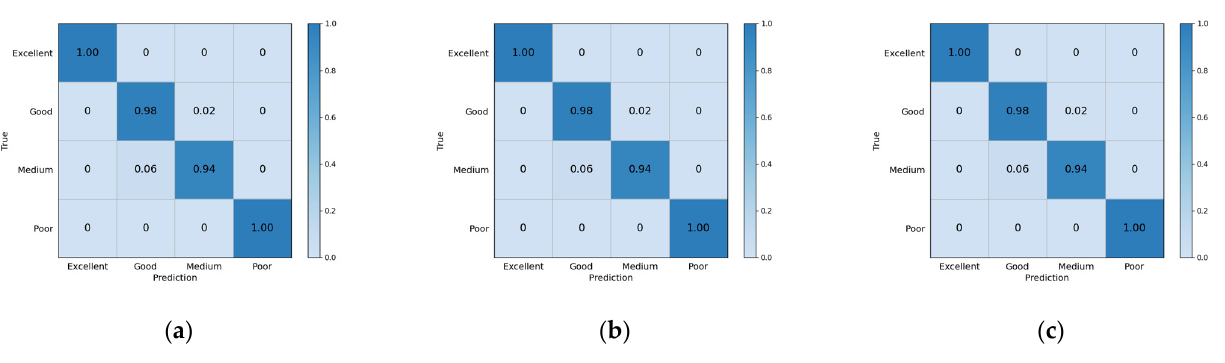
( c ) Figure 10. Confusion matrix for girls’ physical fitness level evaluation. ( a ) Confusion matrix when epoch is 250; ( b ) Confusion matrix when epoch is 300; ( c ) Confusion matrix when epoch is 350. 4. Discussions In the present research, we explored predictability of the running PPGs for the physical fitness levels of teenagers. The wrist-recorded PPGs were found to be an effective indicator of teenagers’ physical fitness condition, with better results for predicting excellent and poor levels. Intermediate health levels are a bit harder to assess. The experiment results indicate that people can monitor physical fitness condition of adolescents by analyzing their physiological recordings with modern artificial intelligence methods. Through mathematical calculation, MF-WT denoising, and PCC value analyses, we finalized the physiological feature set for boys and girls, respectively. Considering the one-dimensional nature, and time correlation, of physiological signals, computing ability, and dimension reduction processing ability of deep learning, we applied 1D-CNN with LSTM to achieve the classified task and got 98.27% (for boys) and 99.26% (for girls) as the final prediction results. Notably, whereas, ideally, it is expected to collect physiological recordings from all items of the student physical fitness test, on the guidance of official documents published by the government, for the prediction of health condition, our data were measured merely by a typical running test. Although cardiopulmonary function can be detected through long-distance running, and running is easier to monitor than sports such as those requiring sitting forward flexion, we admit that if combined with more physical tests, the results can be more accurate. Furthermore, the accuracy of the evaluation model, based on the current method, has reached the commercial level, but if the signals collected from other sports are added in the future, the accuracy will not be known. In summary, the contributions of this paper are summarized as follows: